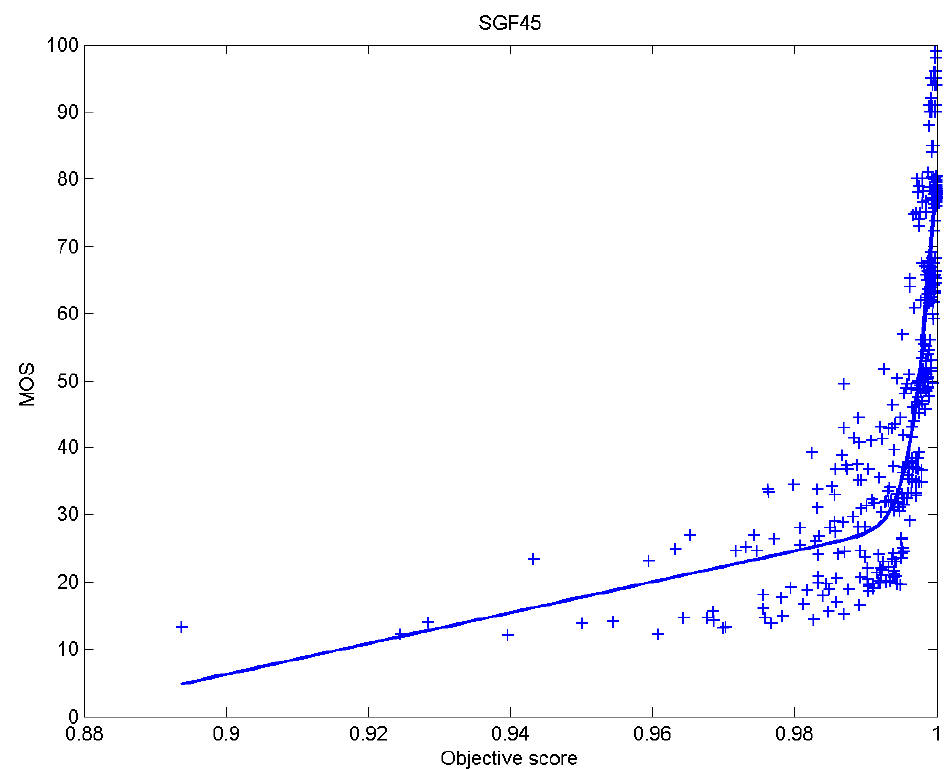
Figure 18. Scatter plots of the subjective scores (MOS) vs. SGF method.